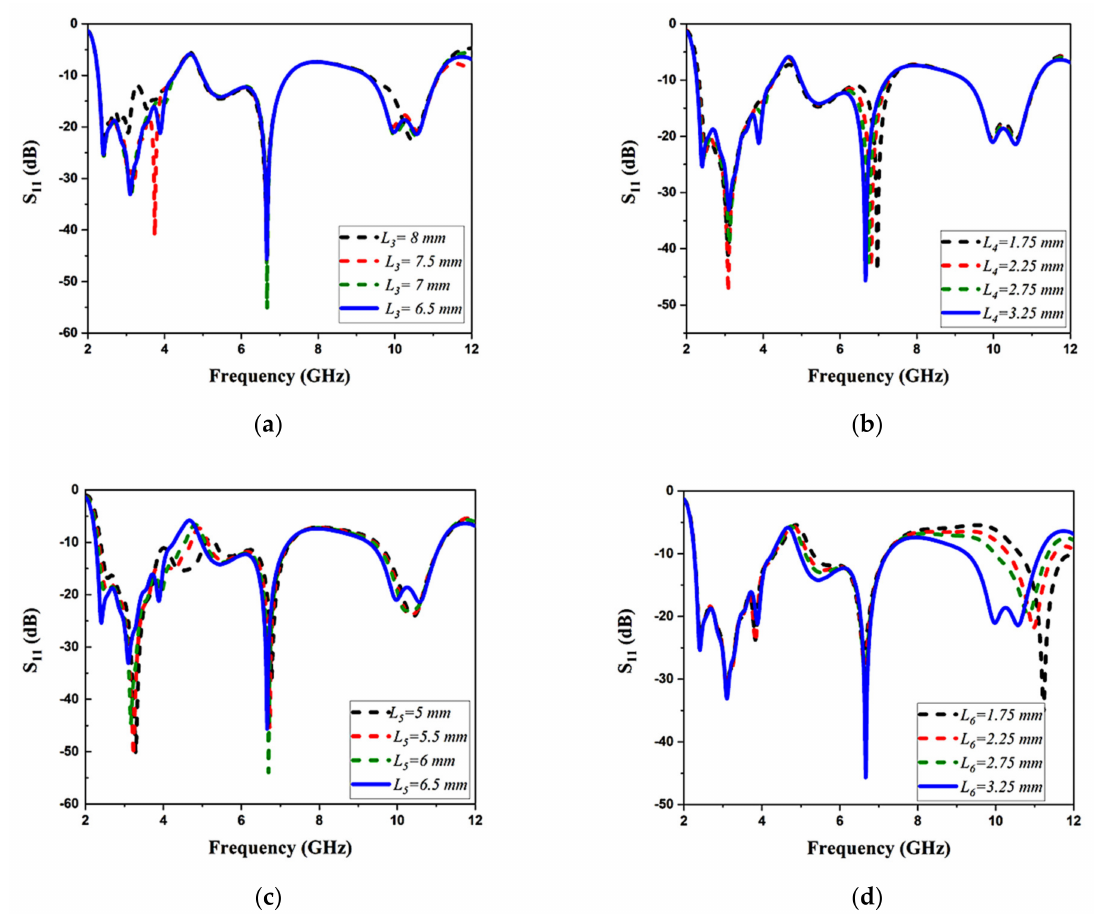
Figure 8. The effect on the reflection coefficient S 11 of ( a ) L 3 ; ( b ) L 4 ; ( c ) L 5 ; ( d ) L 6